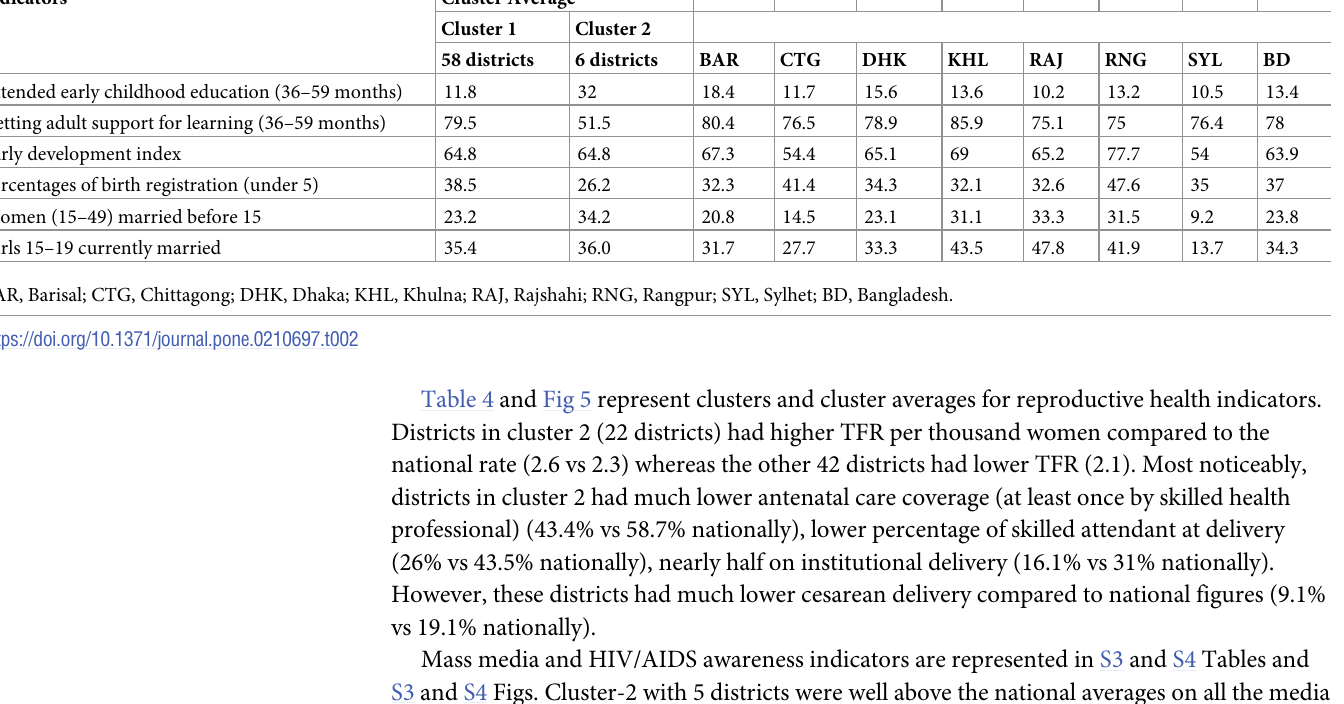
Table 2. Cluster averages of districts along with averages of the divisions and Bangladesh as a whole based on child protection and development indicators. Indicators